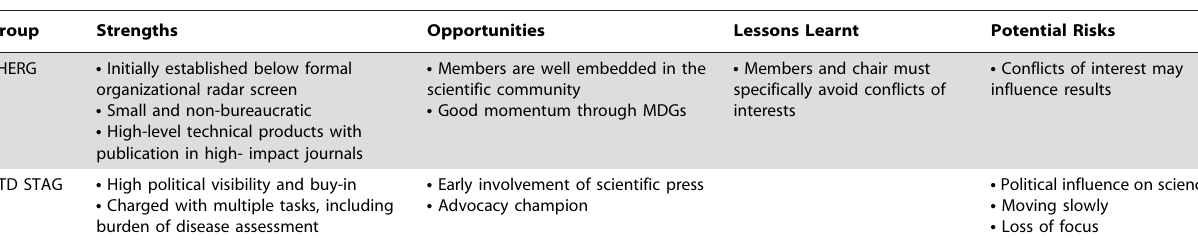
Table 2. In-Depth Case Studies: CHERG and NTD STAG